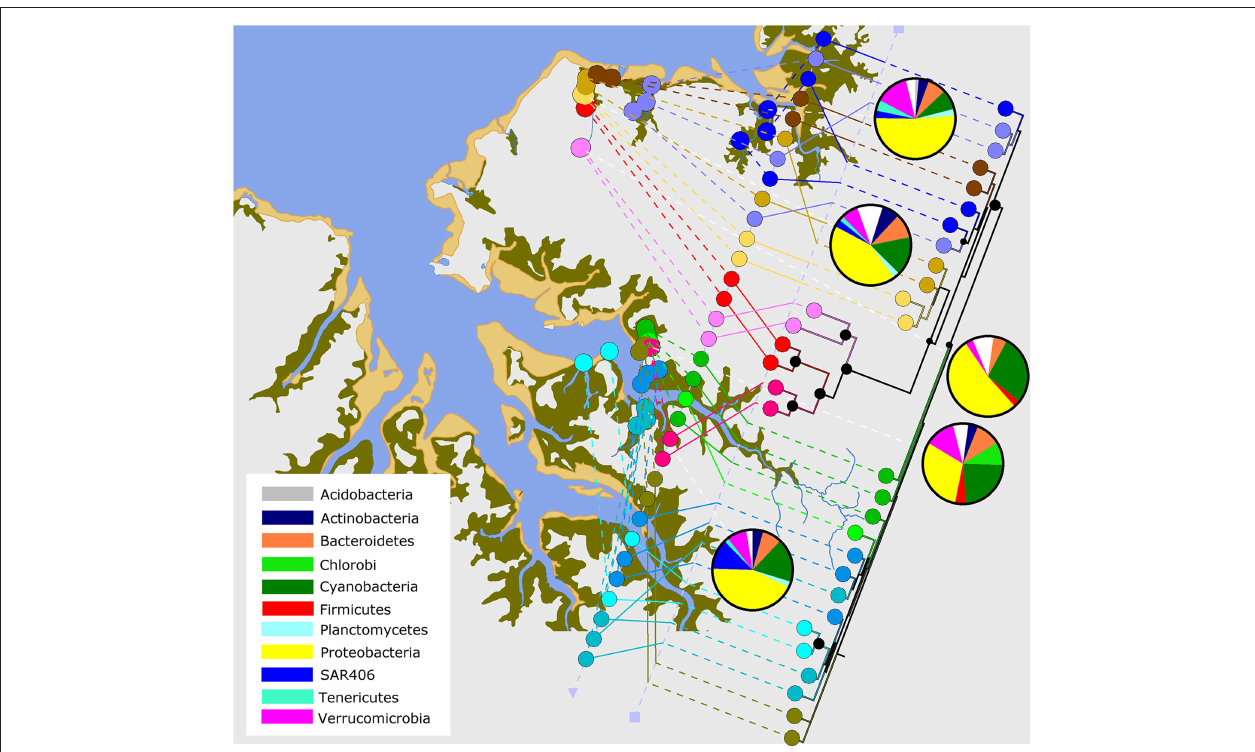
FIGURE 5 | Microbiota relatedness across the harbor. Relatedness of the microbiota in Shoal Bay and East Arm based on a neighbor-joining tree on the weighted UniFrac distance matrix of median water OTU counts per site. A Bootstrap analysis was conducted on 500 resampled trees. Nodes with a black circle indicate > 99% support and smaller circles > 75% support. The tree and pie charts of main bacterial phyla (white for other) were combined with a Darwin Harbour map using GenGIS 2.4.0 (Parks et al.,